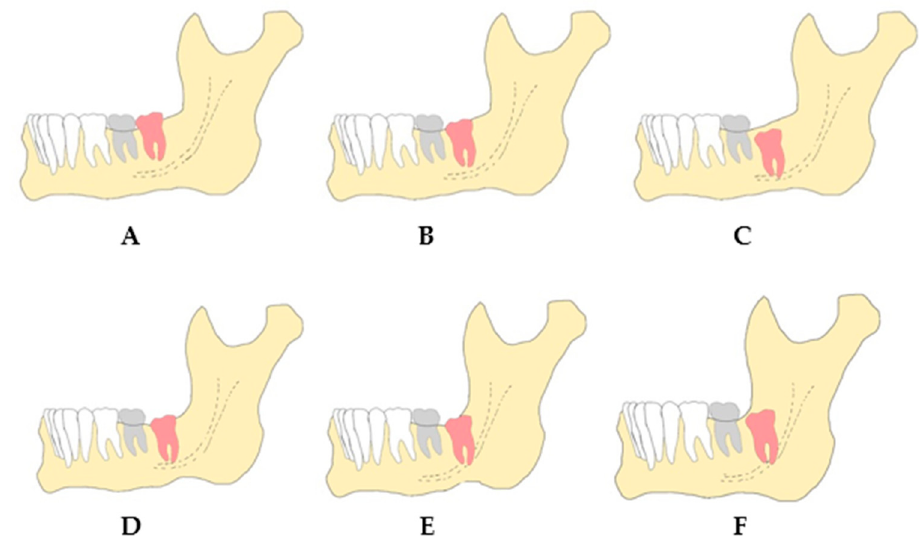
Figure 1. Pell and Gregory classification: ( A ) Class A, ( B ) Class B, ( C ) Class C, ( D ) Class I, ( E ) Class II, and ( F ) Class III.